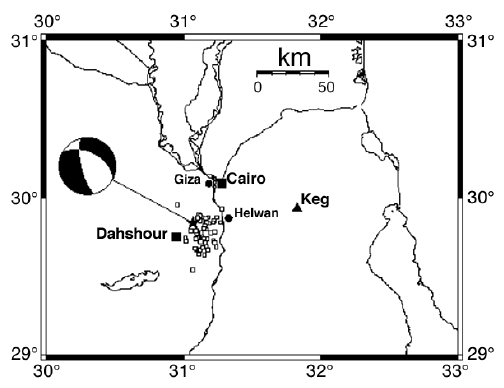
Fig. 1. Aftershocks of Dahshour earthquake of 1992 (open squares). The fault plane solution of the main shock (star) is also